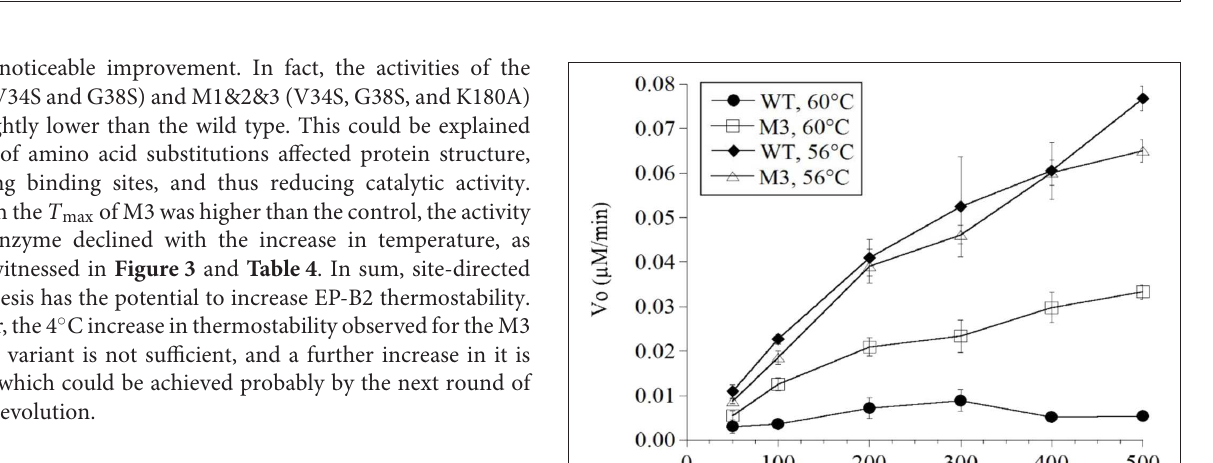
show a noticeable improvement. In fact, the activities of the M1&2 (V34S and G38S) and M1&2&3 (V34S, G38S, and K180A)